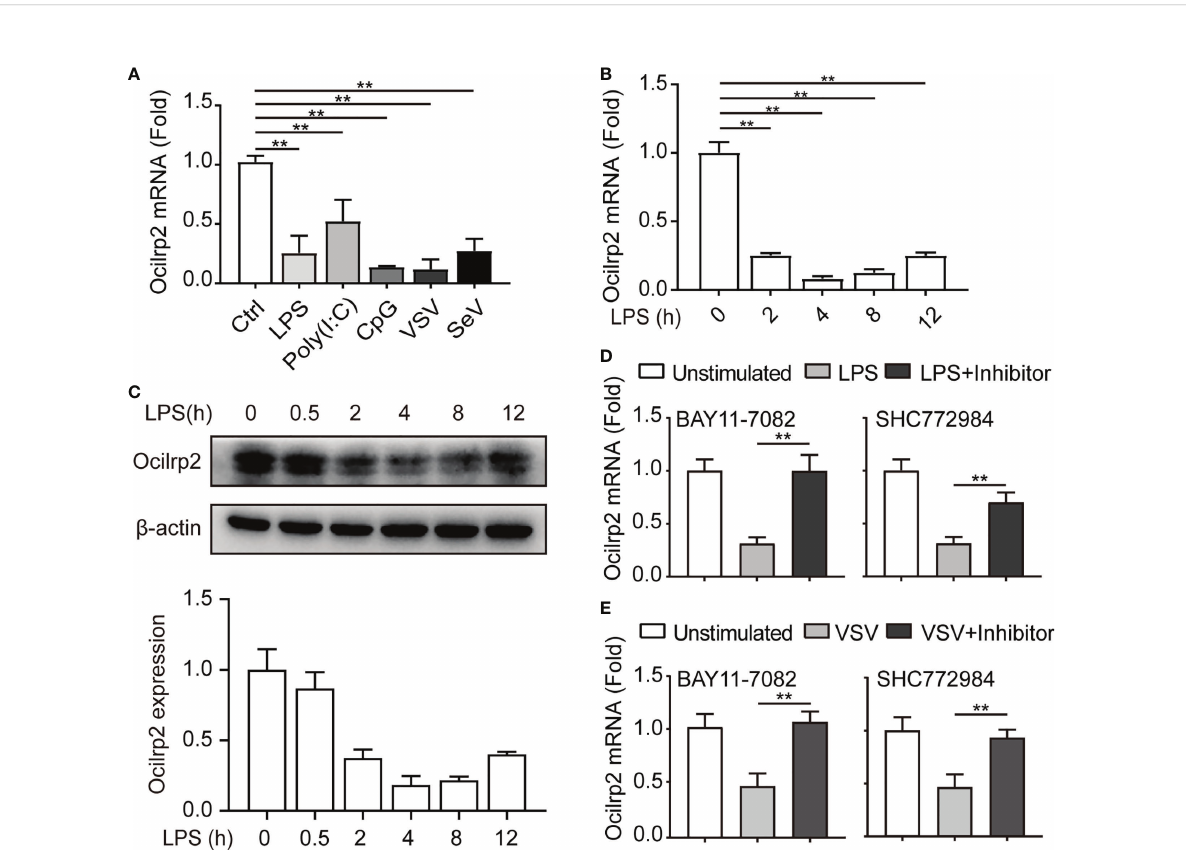
FIGURE 1 Downregulation of Ocilrp2 transcription in macrophages upon innate stimuli. (A) qRT-PCR analysis of Ocilrp2 mRNA levels in mouse peritoneal macrophages following LPS, Poly (I:C) or CpG stimulation or VSV, and SeV infection for 4 h. Data were normalized to the expression of GAPDH. (B) qRT-PCR analysis of Ocilrp2 mRNA levels after LPS stimulation on 2, 4, 8, and 12 h in mouse peritoneal macrophages. Untreated macrophages were used as a control. Data were normalized to the expression of GAPDH. (C) Western Blot analysis of Ocilrp2 protein levels after stimulated by LPS in mouse peritoneal macrophages. Ocilrp2 expression was analyzed by western blotting. Western blots and immuno fl uorescence images are representative of three independent experiments. (D, E) qRT-PCR analysis of Ocilrp2 mRNA level in macrophages treated with NF- k B inhibitor (BAY11-7082) or Erk inhibitor (SCH772984) for 1 h and then stimulated with LPS for 4 h or infected with VSV for 4 h. Data were normalized to the expression of GAPDH. Data were calculated from at least 3 independent experiments (means ± s.e.m.), ** P < 0.01 (The two-tailed Student ’ s